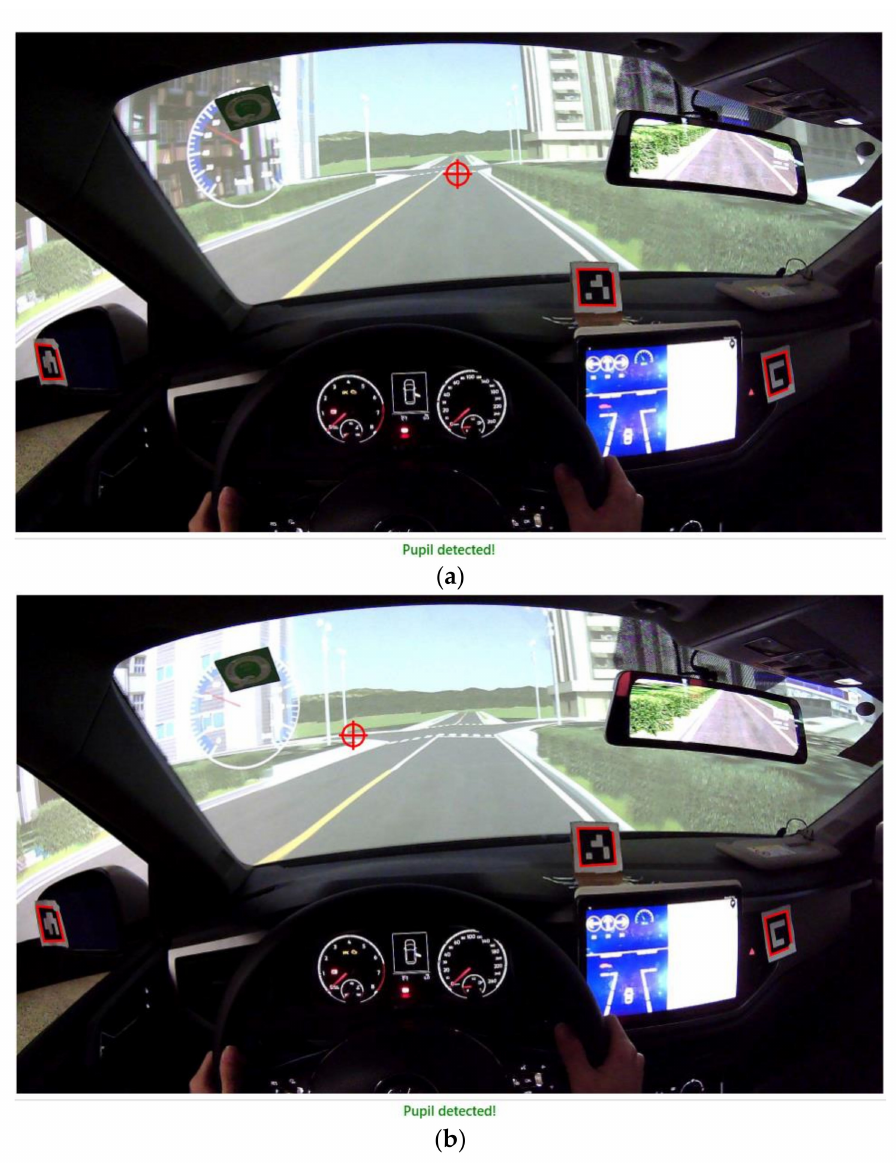
Figure 13. Example of driver’s gaze change processing. ( a ) When the warning was triggered, the driver’s gaze was straight ahead. ( b ) After the warning was triggered, the driver’s gaze focused on the front left. Table 6. Statistics of gaze